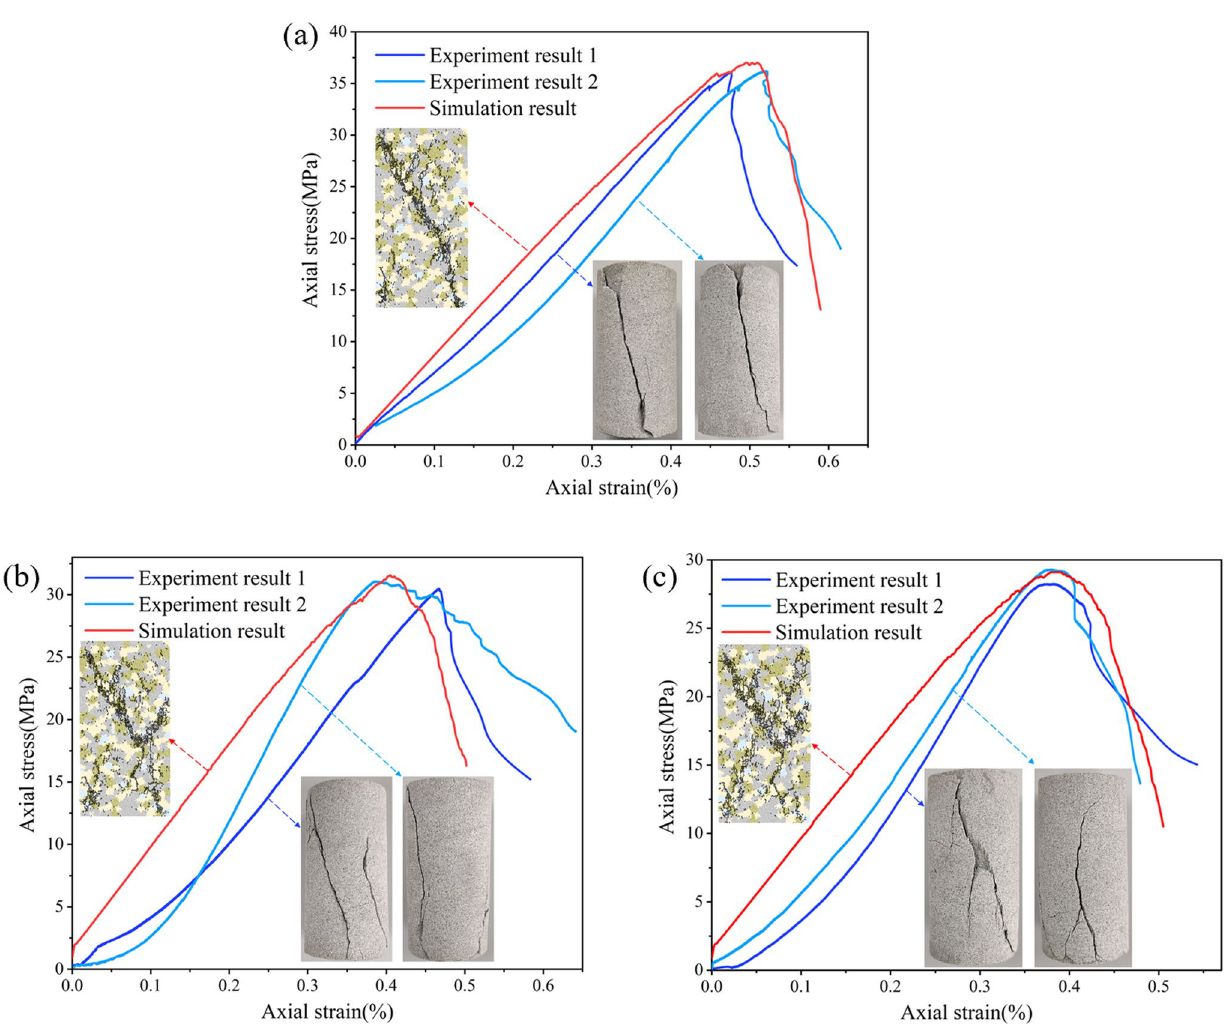
Fig. 6 Calibration results of numerical model a Room temperature b 5 °C/min c 10